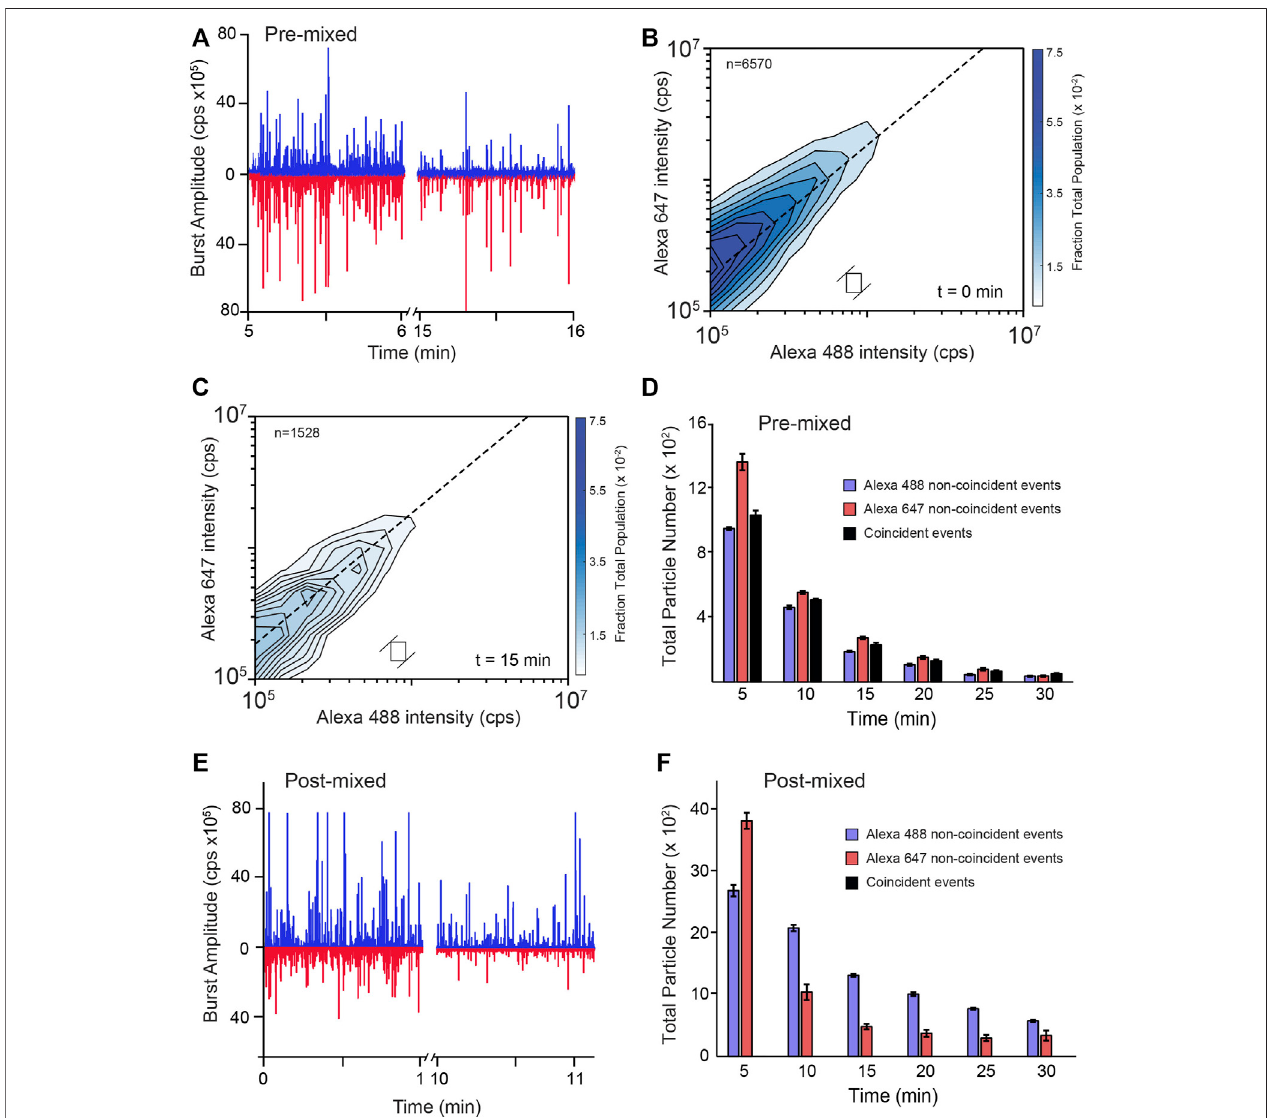
FIGURE 5 | RuBisCO aggregates do not re-form during disaggregation by KJEB. (A) Raw photon histories from a multi-color BAS experiment (MC-BAS; Shoup et al., 2021) in which co-labeled, S-type RuBisCO aggregates were disassembled by KJEB. Aggregates were formed with a 1:1 mixture of two, differently labeled RuBisCO monomers, one carrying asingle Alexa488 dye and the other a single Alexa647 dye (pre-mixed). The Alexa488 and Alexa647 dyes display littleFRET coupling under these conditions (Shoup et al., 2021). Following formation of co-labeled aggregates (10 nM fi nal total monomer), samples were supplemented with 1 µM DnaK, 2 µM DnaJ, 2 µM GrpE, and 200 nM ClpB, 2 mM ATP, and an ATP regeneration system. Aggregate disassembly was monitored in real time with MC-BAS. (B) The size, monomer stoichiometry, and concentration distributions of the co-labeled aggregate particles, prior to the initiation of disaggregation ( t = 0), are displayed in a two-dimensional MC-BAS plot (Shoup et al., 2021). The dashed line shows the 1:1 monomer stoichiometry position. Positions along this diagonal are proportional to particle size and the spread of the distribution orthogonal to the dashed line is proportional to the relative stoichiometry of the two monomers. The total number of co- incident events in the data set is indicated ( n = 6,570) and the size a raw MC-BAS pixel and its associated ratio range, which were used to calculate the interpolated contourplot, isillustrated withthe open box. (C) The co-labeledMC-BASdistributionafter 15 minofdisassembly isshown. TheMC-BAShistograms are acombination of n =3independentexperimentalreplicates. (D) Thenumber ofco-labeled(i.e.,coincident) aggregateparticlesobservedasafunctionoftimeisshown,compared with the number of particles that are only detectable in one or the other channel (i.e., non-coincident). (E) Raw photon histories of an MC-BAS experiment in which each labeled monomer was separately aggregated and mixed with the KJEB system for 3 min, prior to co-mixing (post-mixed). Aggregation conditions, fi nal total monomer and KJEB component concentrations are identical to the pre-mixed experiment (A – D) . (F) The number of particles detectable in only one or the other channel as a functionoftimeisshown.Noparticlesdisplayingsigni fi cantcoincidenceweredetectableoverthecourseofthedisassemblyexperiment.Errorbarsdisplaythestandard deviation for the total number of particles detected at each time point from n = 3 independent experimental replicates.